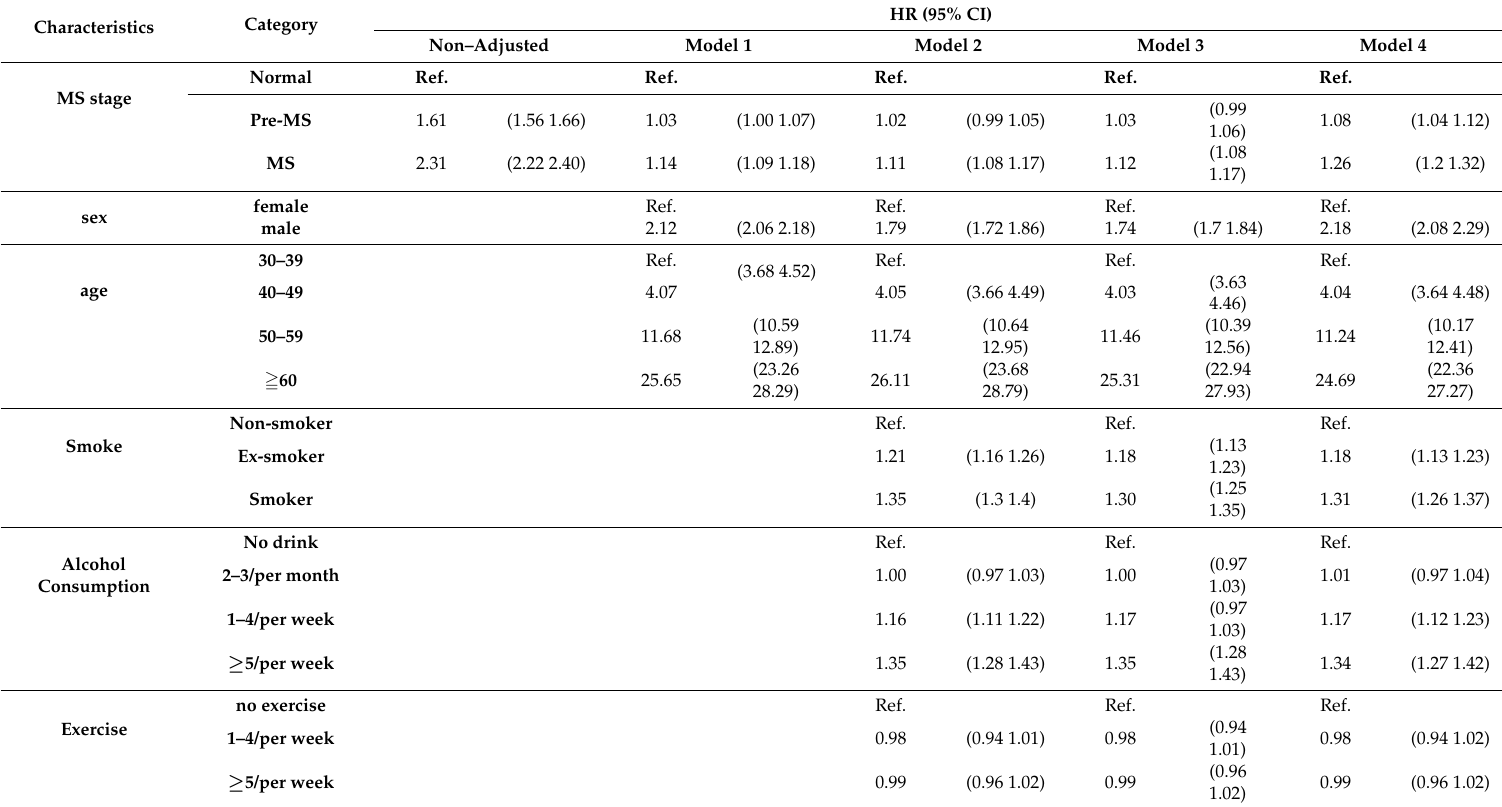
Table 3. Hazardous ratio (HR) incidence rates of gastric cancer according to the progression of metabolic